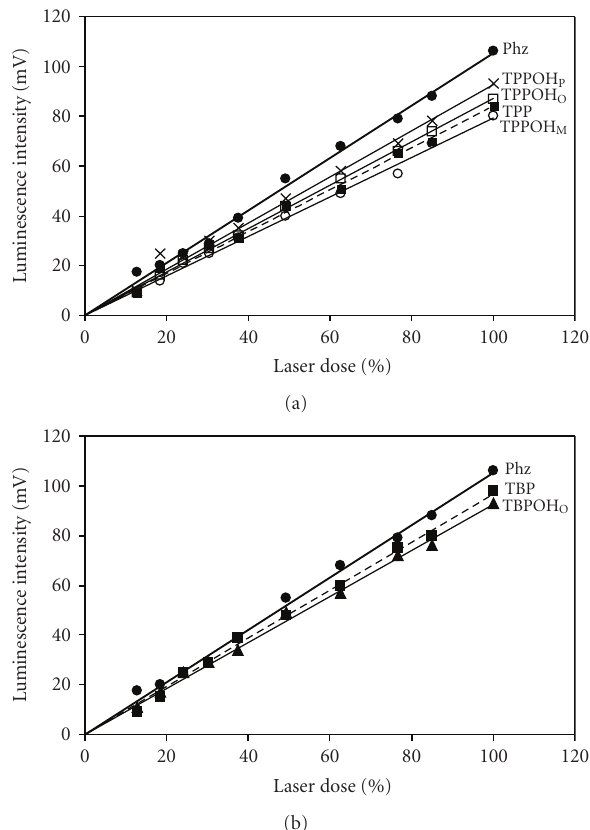
Figure 6: Plots of initial singlet oxygen ( 1 O 2 ) luminescence intensity versus laser dose percentage for optically matched samples (O.D. = 0.30) of (a) Phenazine, (TPP ( ), TPPOH O , TPPOH M , and TPPOH P and (b) Phenazine ( ), TBP ( ) and TBPOH O . Air equilibrated samples in benzene at room temperature; excita- tion wavelength was 337nm.